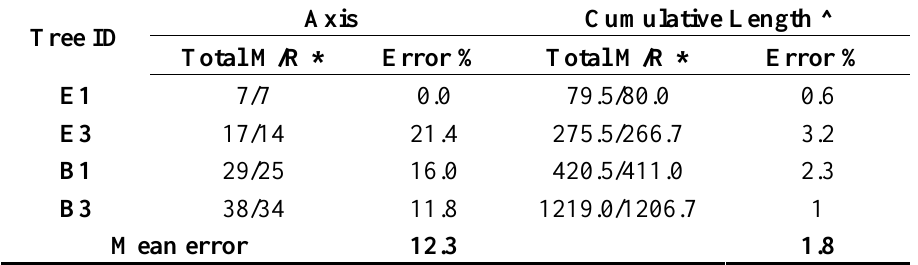
Table 3. Validation results for the semi-supervised reconstruction of 3-year-old sugar maple (E1 and E3) and yellow birch (B1 and B3) saplings that were grown under contrasting light regimes. Axis ordering system is based on Barthelemy and Caraglio